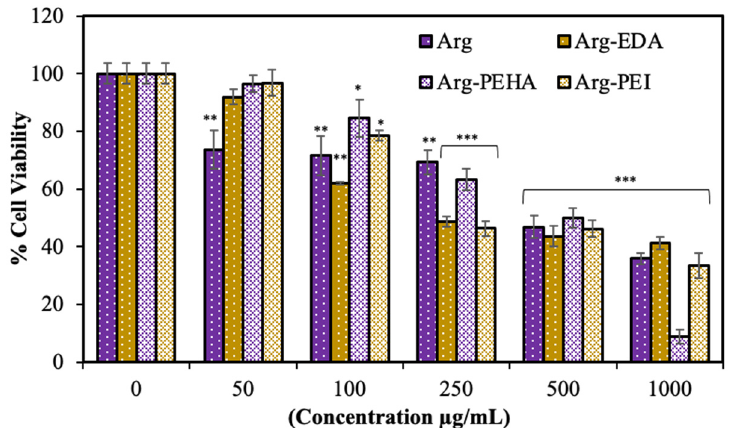
Figure 5. Cytotoxicity of Arg CDs and their modified forms, Arg-EDA, Arg-PEHA, and Arg-PEI CDs, on L929 fibroblast cells for 24 h incubation time [* p < 0.05, ** p < 0.01, *** p < 0.001 vs. control]. The antimicrobial properties of the Arg, Arg-EDA, Arg-PEHA, and Arg-PEI CDs were investigated against gram-negative E. coli and gram-positive S. aureus bacteria strains by microtiter tests. The results of the minimum inhibition concentration (MIC, mg/mL) values of Arg-based CDs are given in Figure 6. The MIC value of Arg CDs was found to be 3.12 mg/mL against both E. coli and S. aureus species. The MIC values of Arg- EDA and Arg-PEHA CDs were not changed against S. aureus ; however, a two-fold de- crease against E. coli , with a 1.75 mg/mL MIC value, was observed. These results indicate that Arg-EDA and Arg-PEHA CDs have almost the same antibacterial effects on gram-